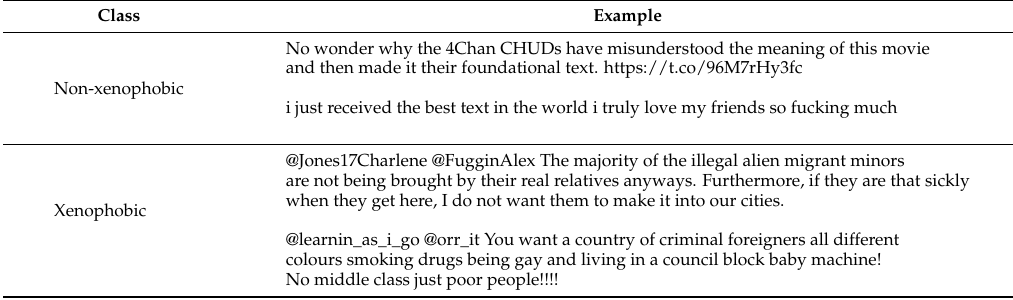
Table 2. Examples of tweets classified as xenophobic, non-xenophobic.